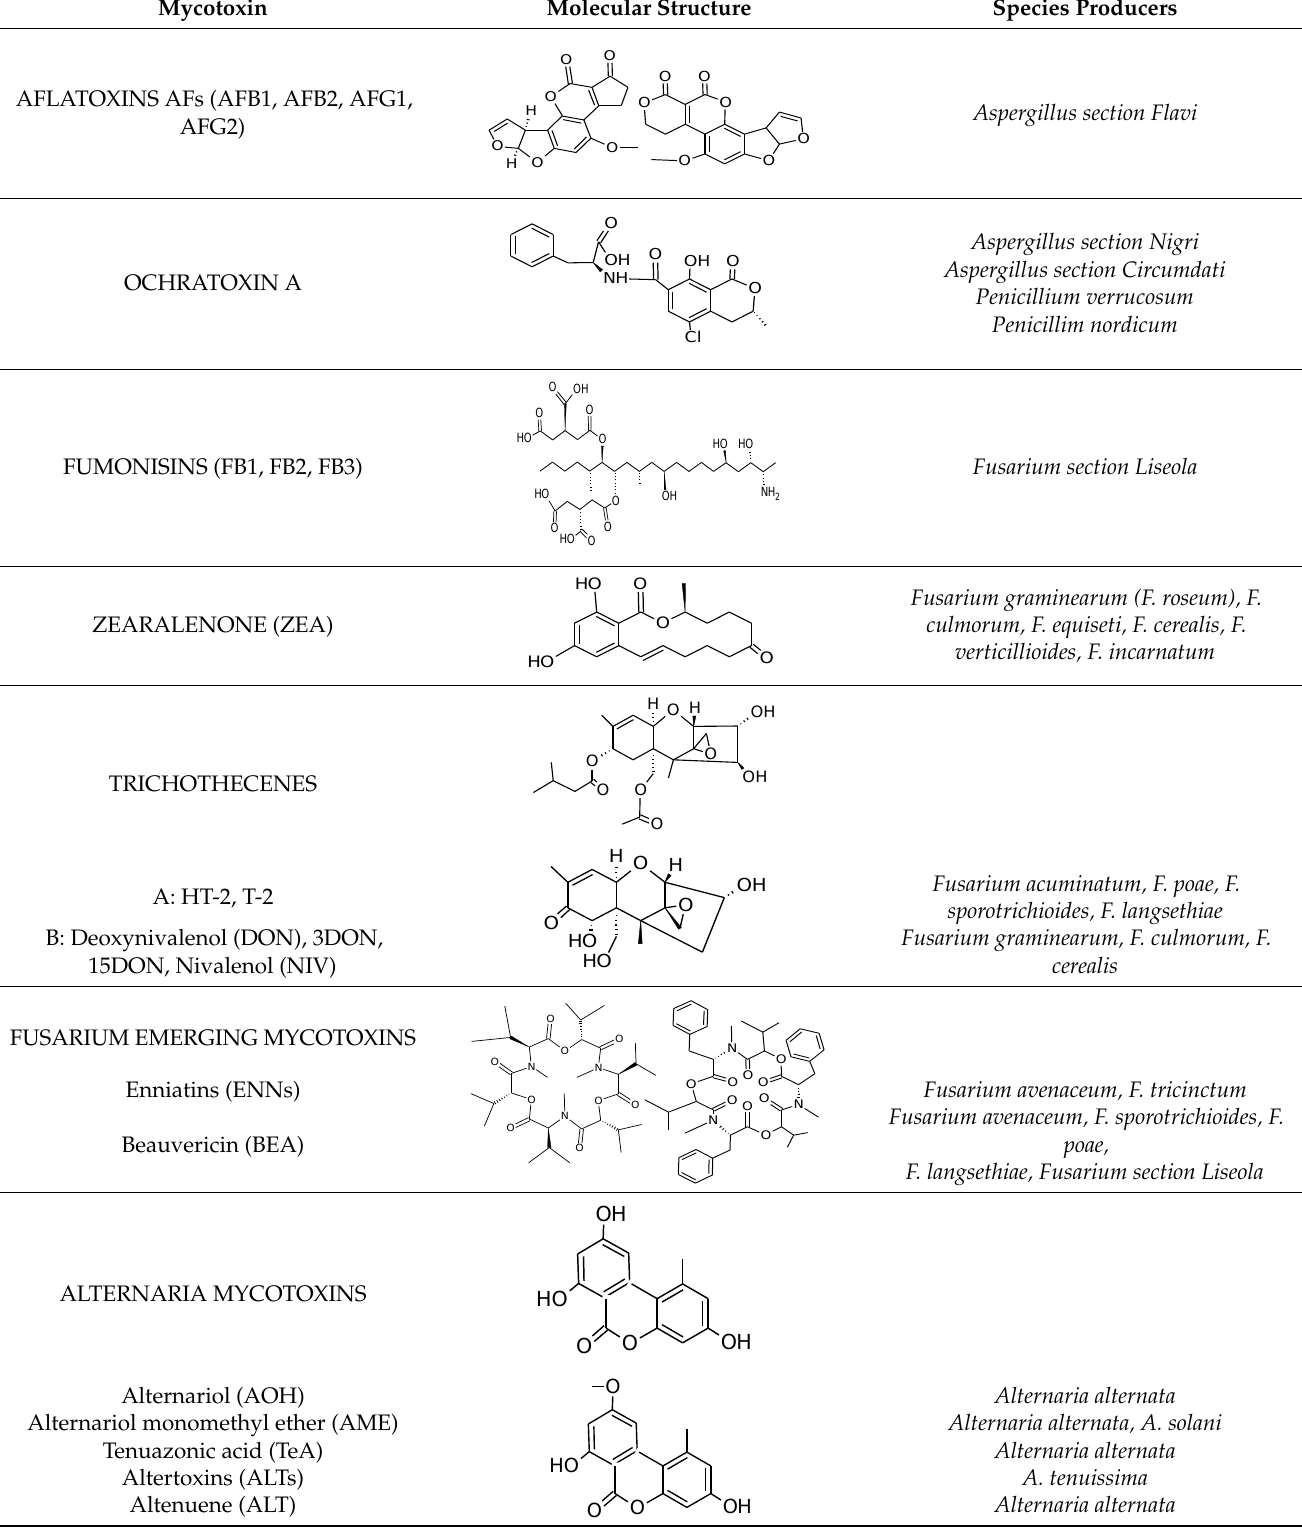
Table 1. Most relevant mycotoxins and their species producers.